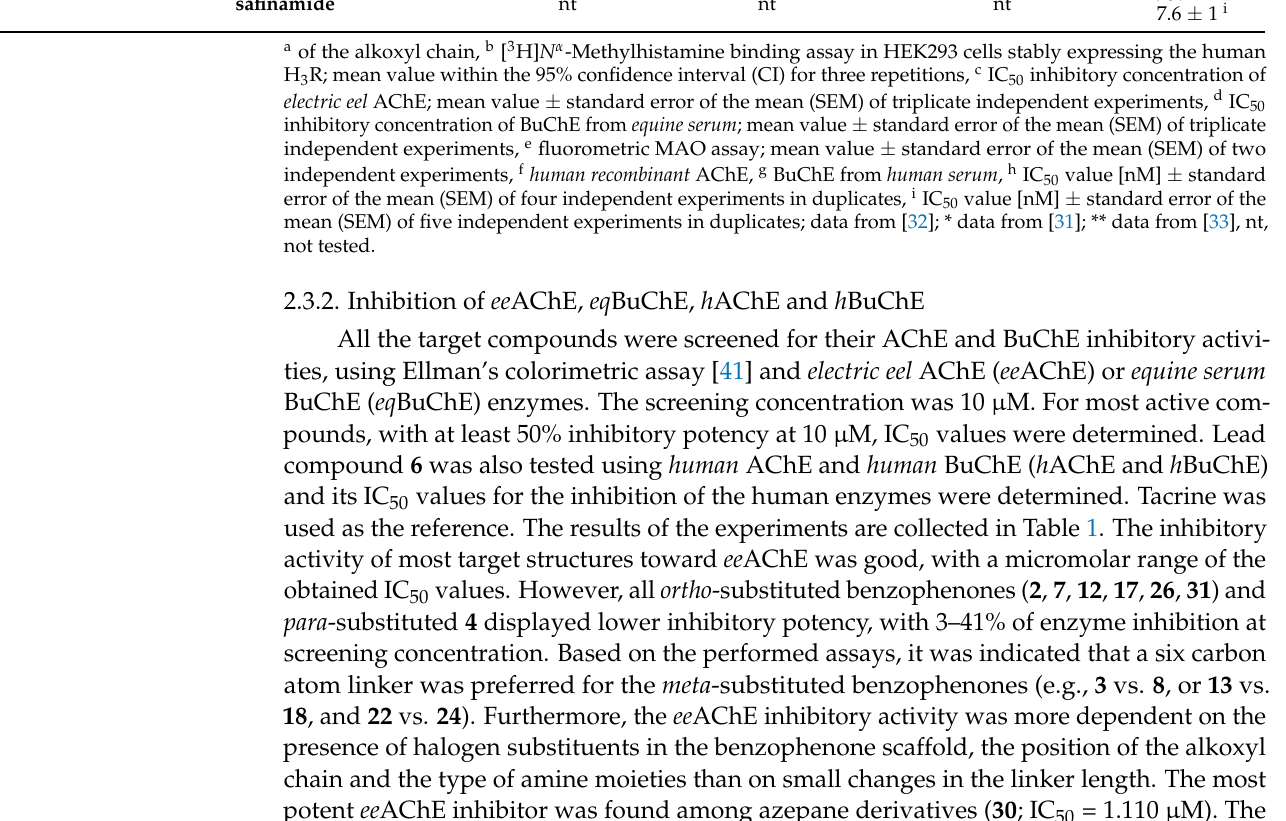
the human H 3 R; mean value within the 95% confidence interval (CI) for three repetitions, c IC 50 in ‐ hibitory concentration of electric eel AChE; mean value ± standard error of the mean (SEM) of tripli ‐ cate independent experiments, d IC 50 inhibitory concentration of BuChE from equine serum ; mean value ± standard error of the mean (SEM) of triplicate independent experiments, e fluorometric MAO assay; mean value ± standard error of the mean (SEM) of two independent experiments, f human recombinant AChE, g BuChE from human serum , h IC 50 value [nM] ± standard error of the mean (SEM) of four independent experiments in duplicates, i IC 50 value [nM] ± standard error of the mean (SEM) of five independent experiments in duplicates; data from [32]; * data from [31]; ** data from [33], nt, not